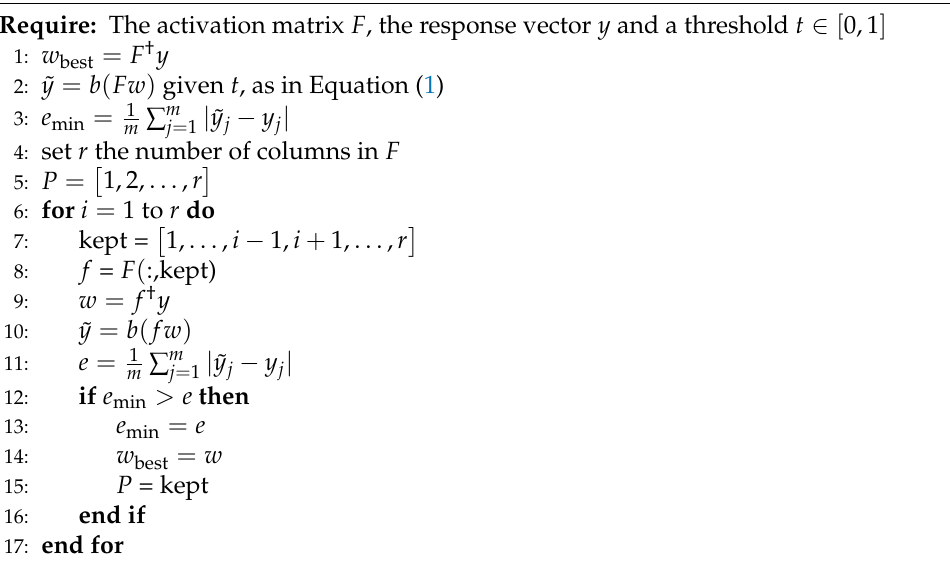
Algorithm 3 Hidden layer trimming process